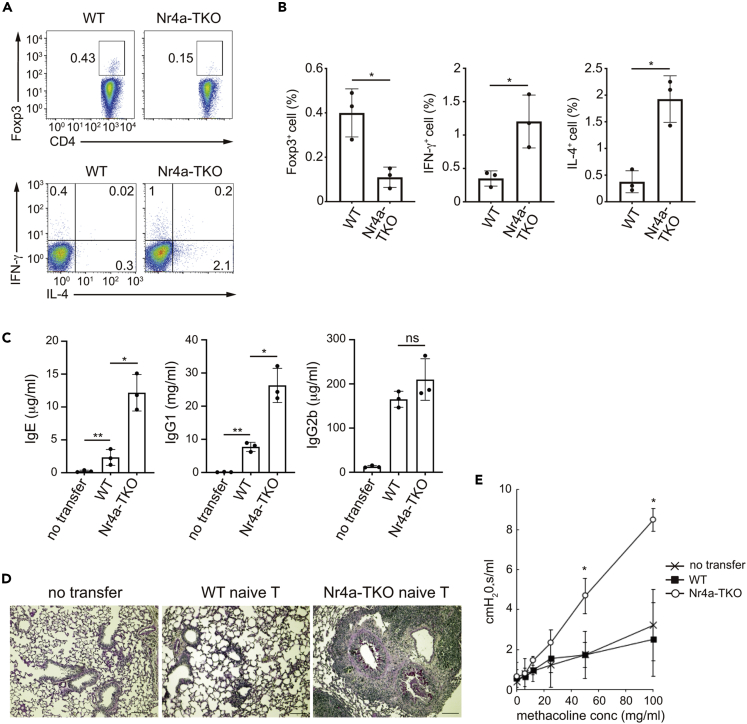
Nr4a factors are important for the induction of pTreg cells and the repression of Th1 and Th2 cell differentiation from naive T cells in vivo(A) Flow cytometry profiles of total CD3+CD4+ cells from spleens of TCRβ−/- recipient mice that received WT and Nr4a-TKO naive T cells.(B) Quantification of the result in (A). Black dots represent individual values. Vertical bars and the error bars indicate mean and SD, respectively.(C) Titers of IgE, IgG1, and IgG2b in sera collected from untreated TCRβ−/- mice and TCRβ−/- mice receiving WT and Nr4a-TKO naive T cells (n = 3 per group). Black dots represent individual values. Vertical bars and the error bars indicate mean and SD, respectively.(D) PAS staining of lung sections from untreated TCRβ−/- mice and TCRβ−/- mice receiving WT and Nr4a-TKO naive T cells. Scale bars, 100 μm.(E) flexiVent system-mediated airway resistance measurement in response to methacholine challenge in untreated TCRβ−/- mice and TCRβ−/- mice receiving wild-type and Nr4a-TKO naive T cells. Each marker and the error bar denote mean and SD, respectively.Data represent three independent experiments, n = 3 per group (A)-(E). ∗p < 0.05; ∗∗p < 0.01. Unpaired Student's t-test (B), one-way ANOVA with Bonferroni test (C), two-way ANOVA with Sidak test (E). See also Figure S2.